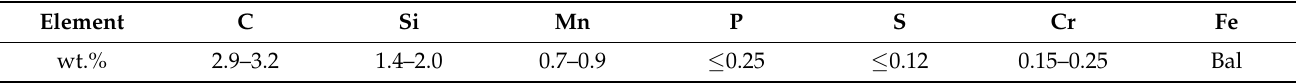
Figure 1. Micromorphology distribution of graphite on the surface of Ht250 cast iron. Table 1. Main components of Ht250 cast iron.